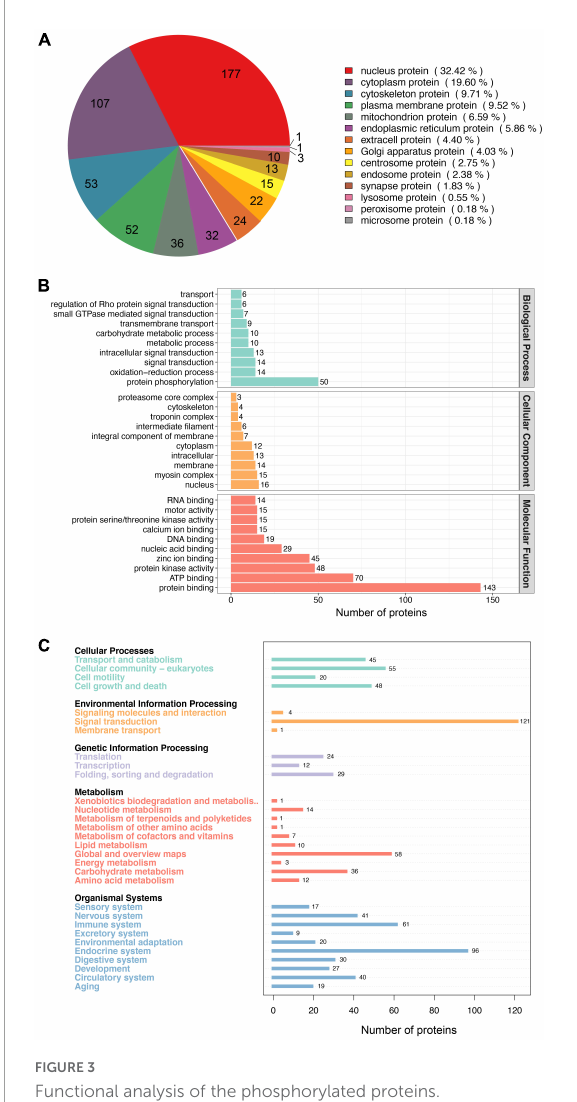
FIGURE3 Functional analysis of the phosphorylated